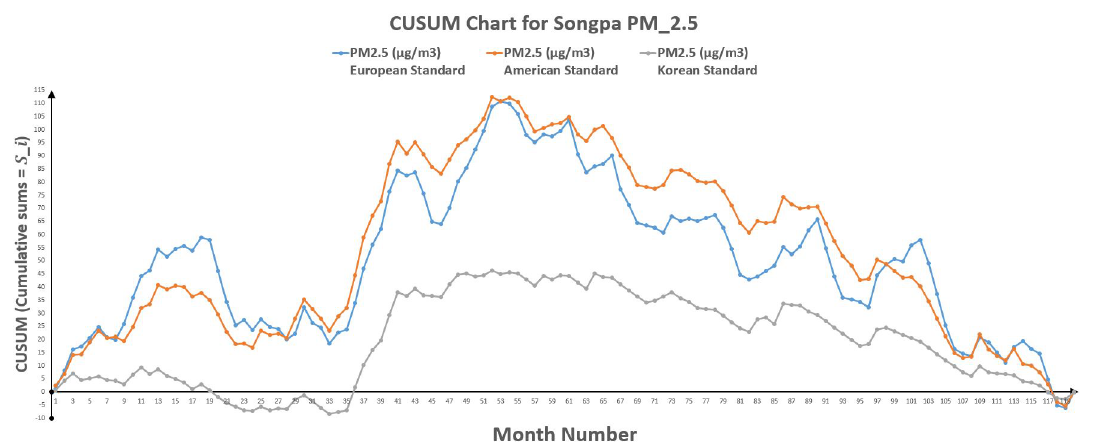
Figure 6. CUSUM chart for Songpa PM 2.5